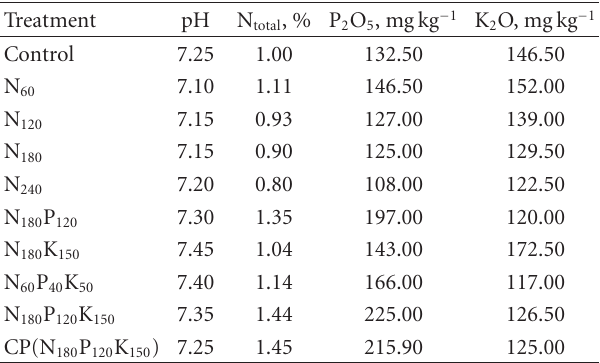
Table 1: Soil agrochemical mean parameters of seminatural grassland and cultural pasture (CP) at the end of vegetation period (2009) ( P < 0 .